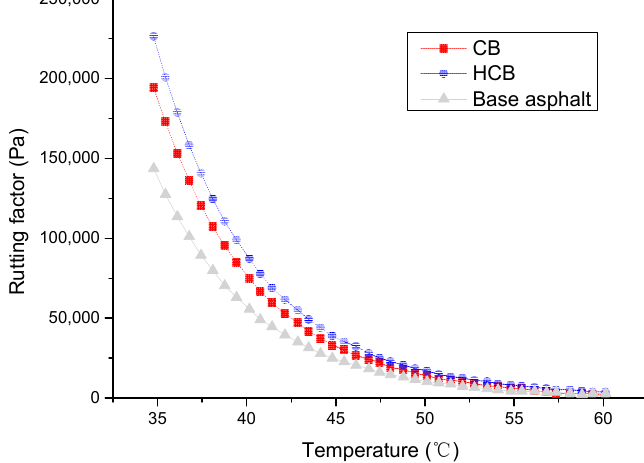
Figure 7. Effect of CB and HCB on phase angle of asphalt.